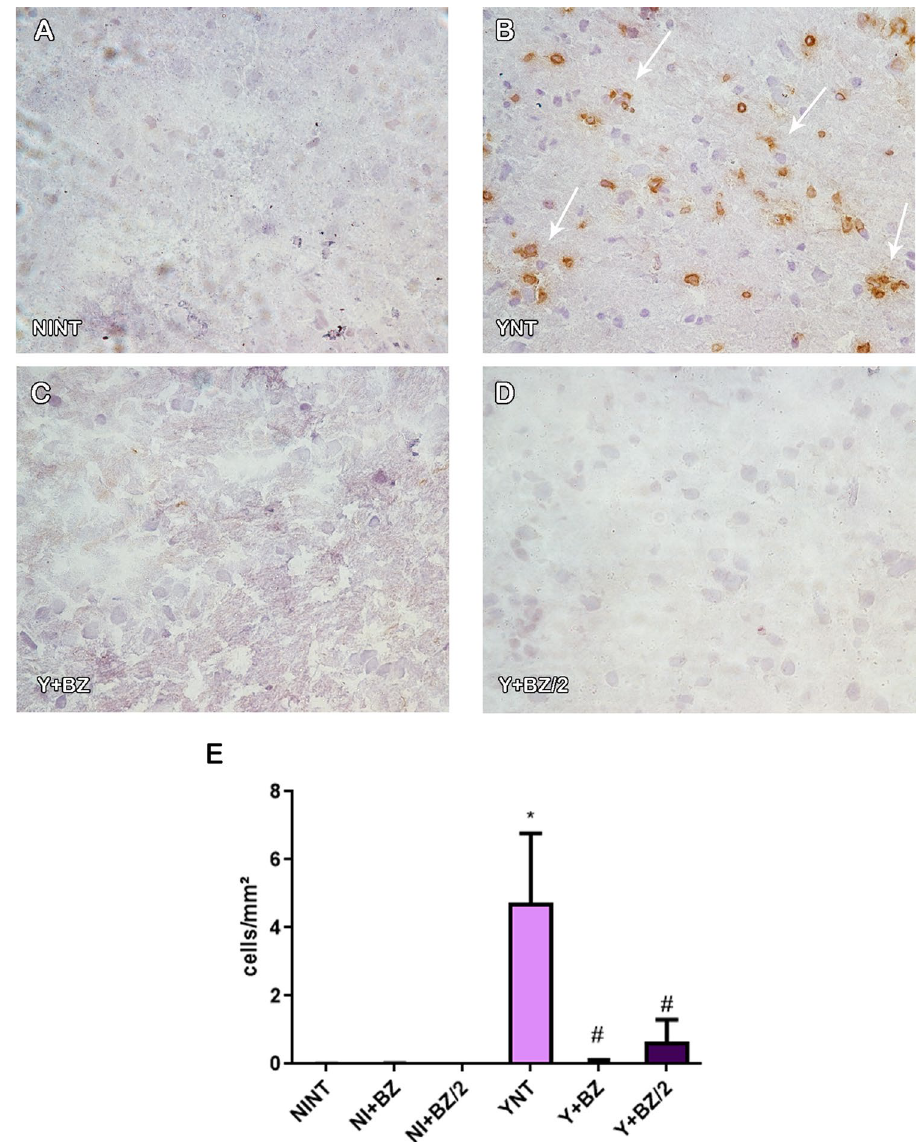
Figure 5. Analysis of the number of CD3+ cells by immunohistochemistry in mice’s brain at 15 dpi. YNT group ( B ) had an increased number of CD3+ cells when compared to NINT group ( A ). Treatment with BZ and BZ/2 ( C and D ) prevented this increase. Graphic indicate the number of cells per mm 2 ( E ). Arrows shows positive cells. NI, non infected; Y, infected; NT, non treated; BZ, treated with benznidazole (100 mg/kg/day); BZ/2, treated with benznidazole (50 mg/kg/day); dpi, days post-infection. *when compared to NINT; # when compared to YNT *p < 0.05, **p < 0.01, ***p <